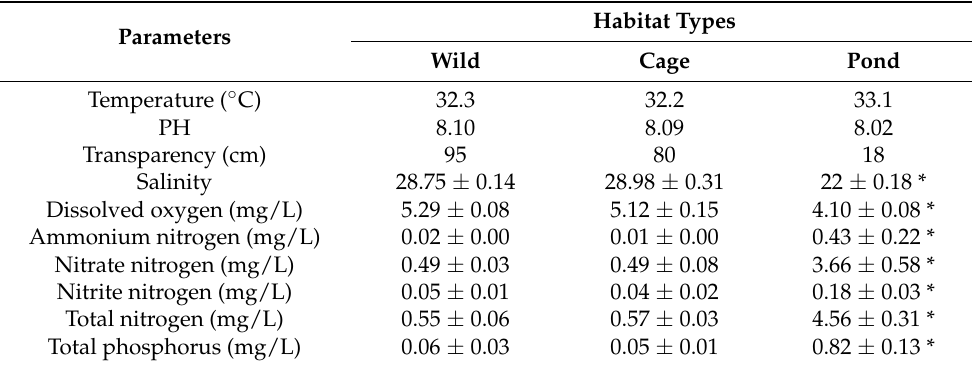
Table 1. The main water quality parameters in different